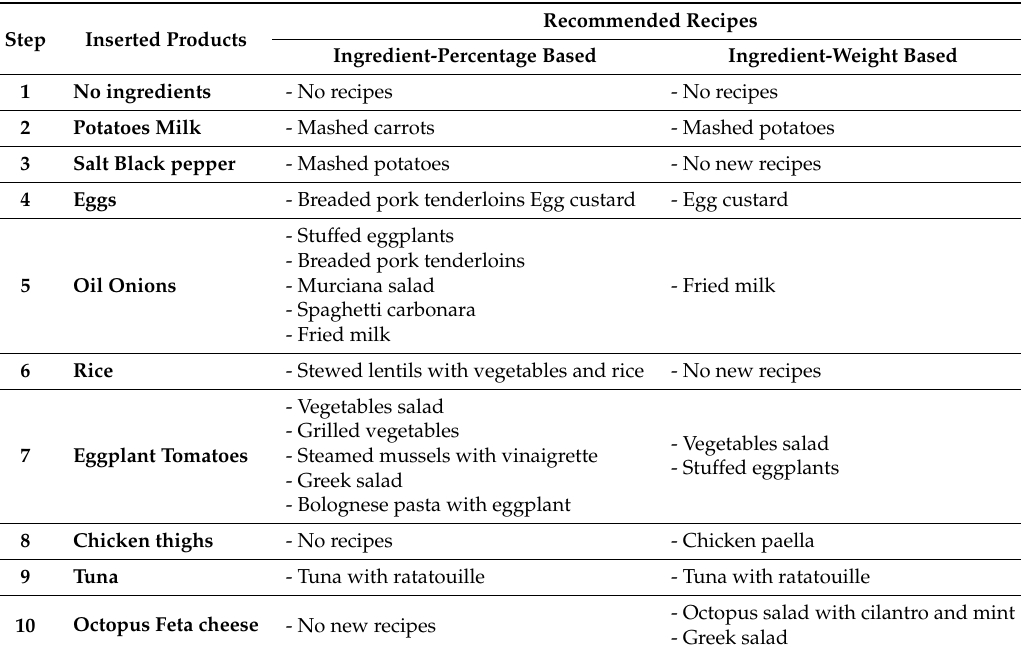
Figure 7. Elements used to evaluate our approaches. Table 4. Algorithm